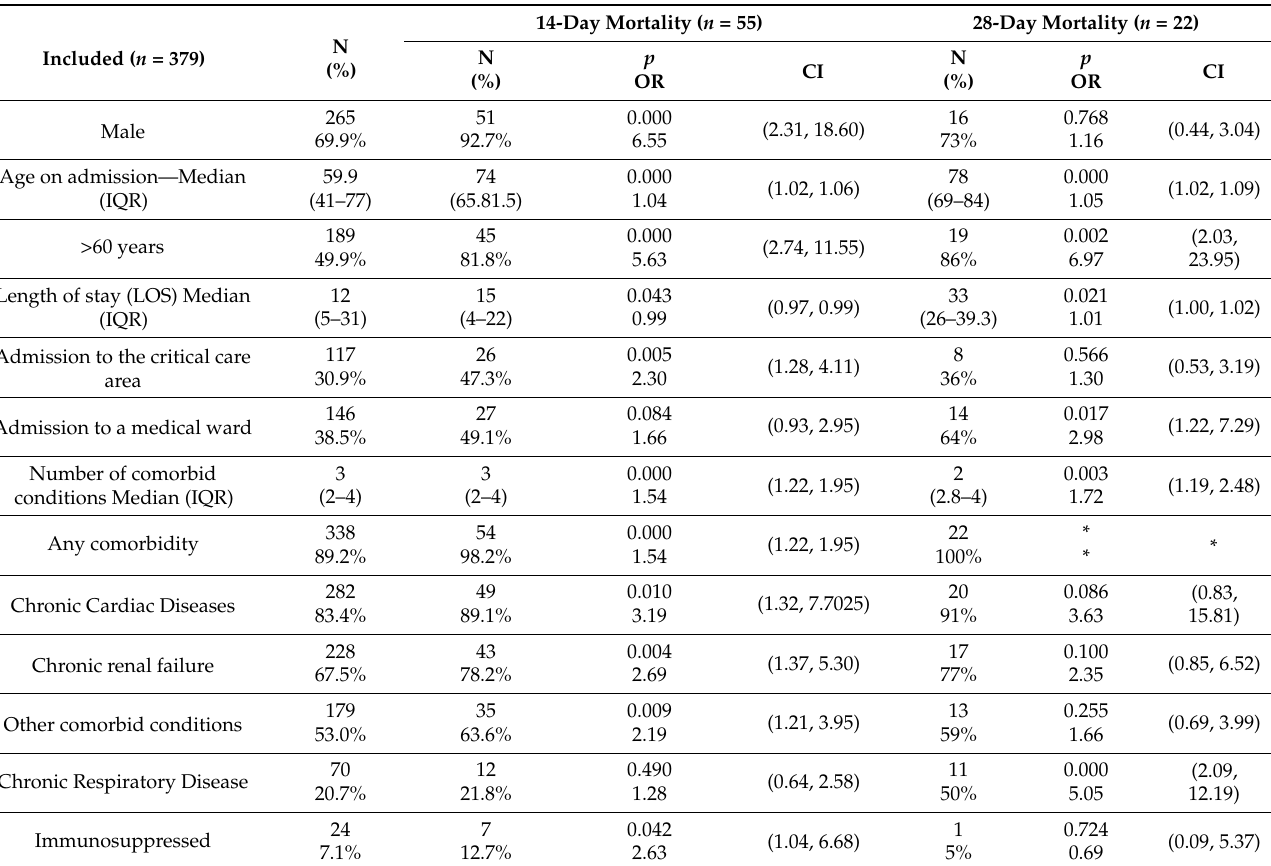
Table 3. Risk factors for 14 and 28-day mortalities (Binary logistic regression). Check Appendix A for comprehensive statistical